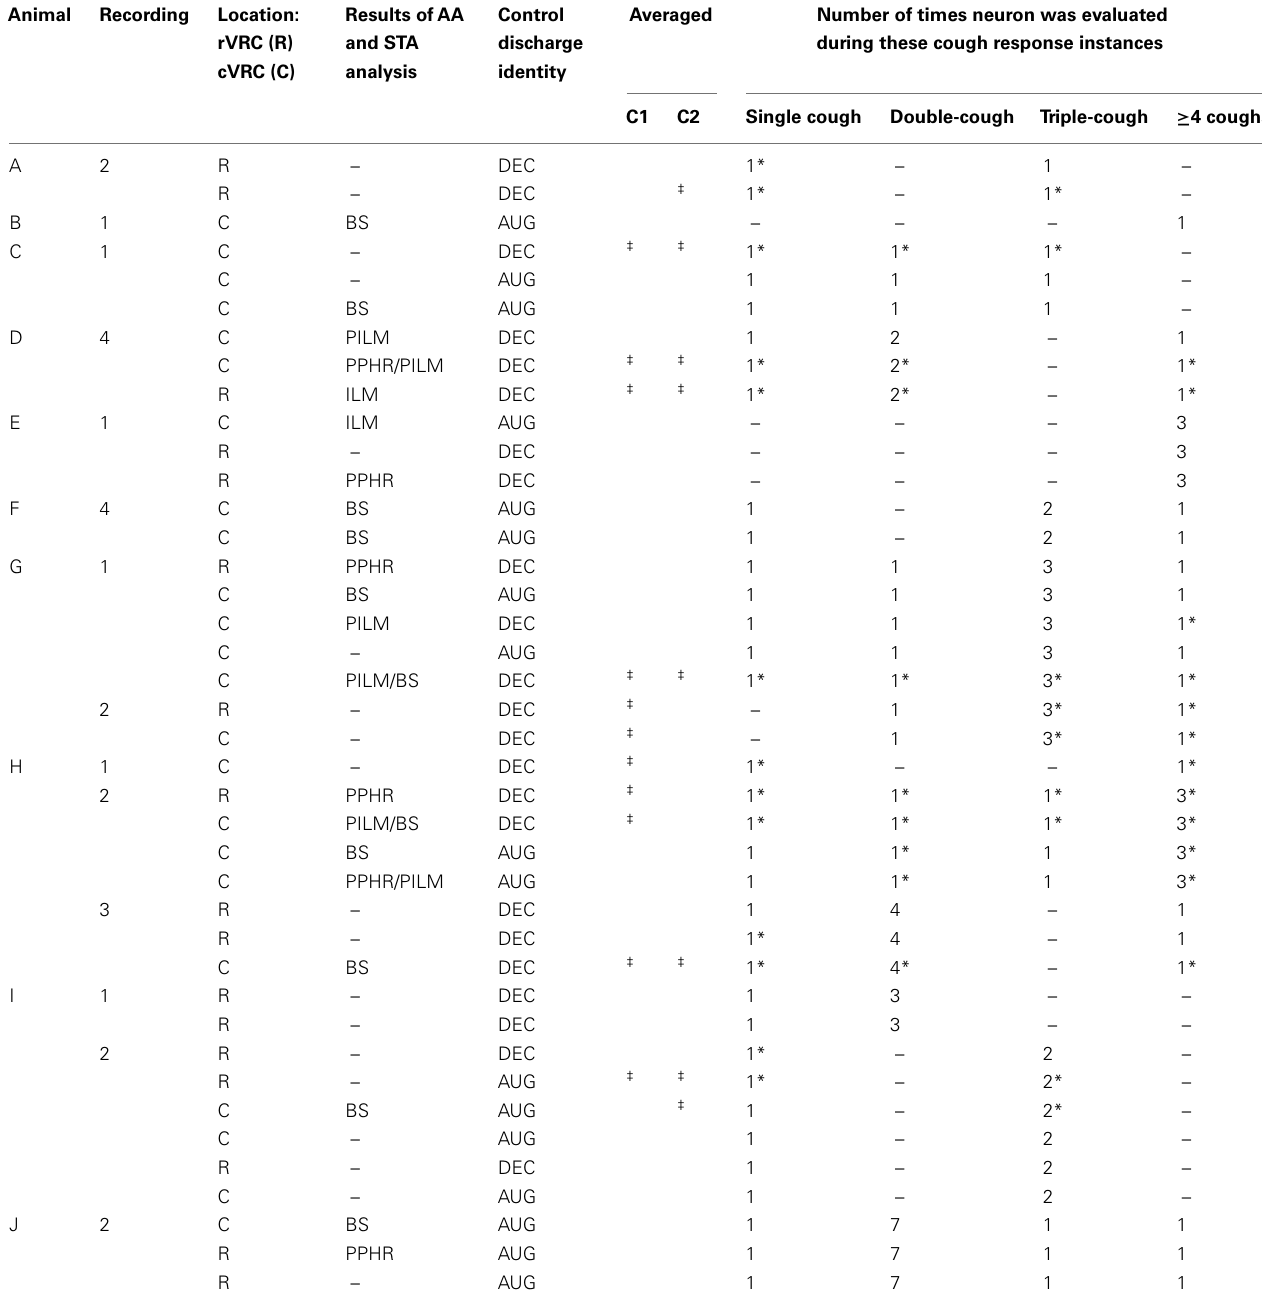
Table 1 | Detailed recording and response information.